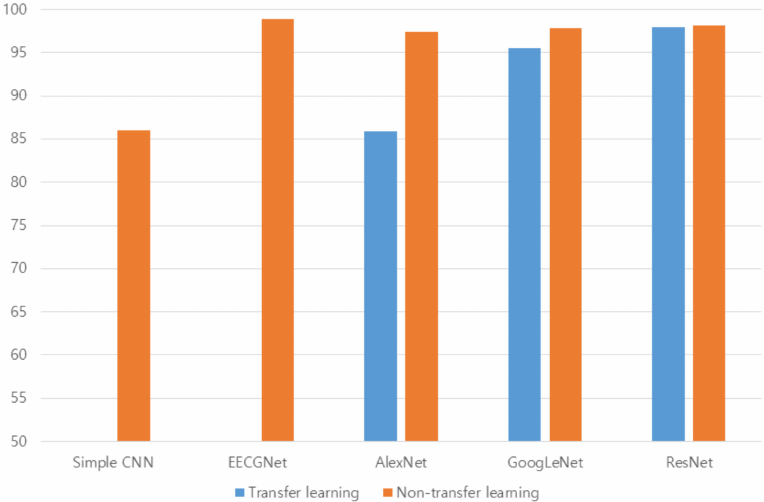
Figure 17. Comparison of the highest accuracies between transfer and nontransfer learning on PTB-ECG.